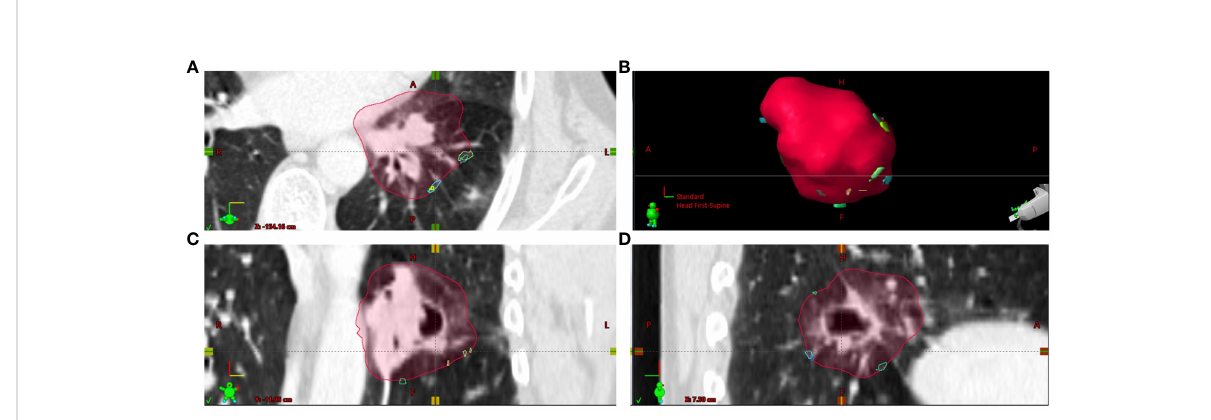
FIGURE 4 The localizations of Hausdorff points from the different dose fractions i (HDP i ) transferred to CT plan by deformable image registration are shown at the outer edge of the CTV plan contour for patient (A) Most HDP i on the CTV plan contour were inferior to the CTV plan center. (A) Axial plane through CTV plan ; (B) 3D view on CTV plan surface; (C) frontal plane through CTV plan ; (D) sagittal plane through CTV plan .